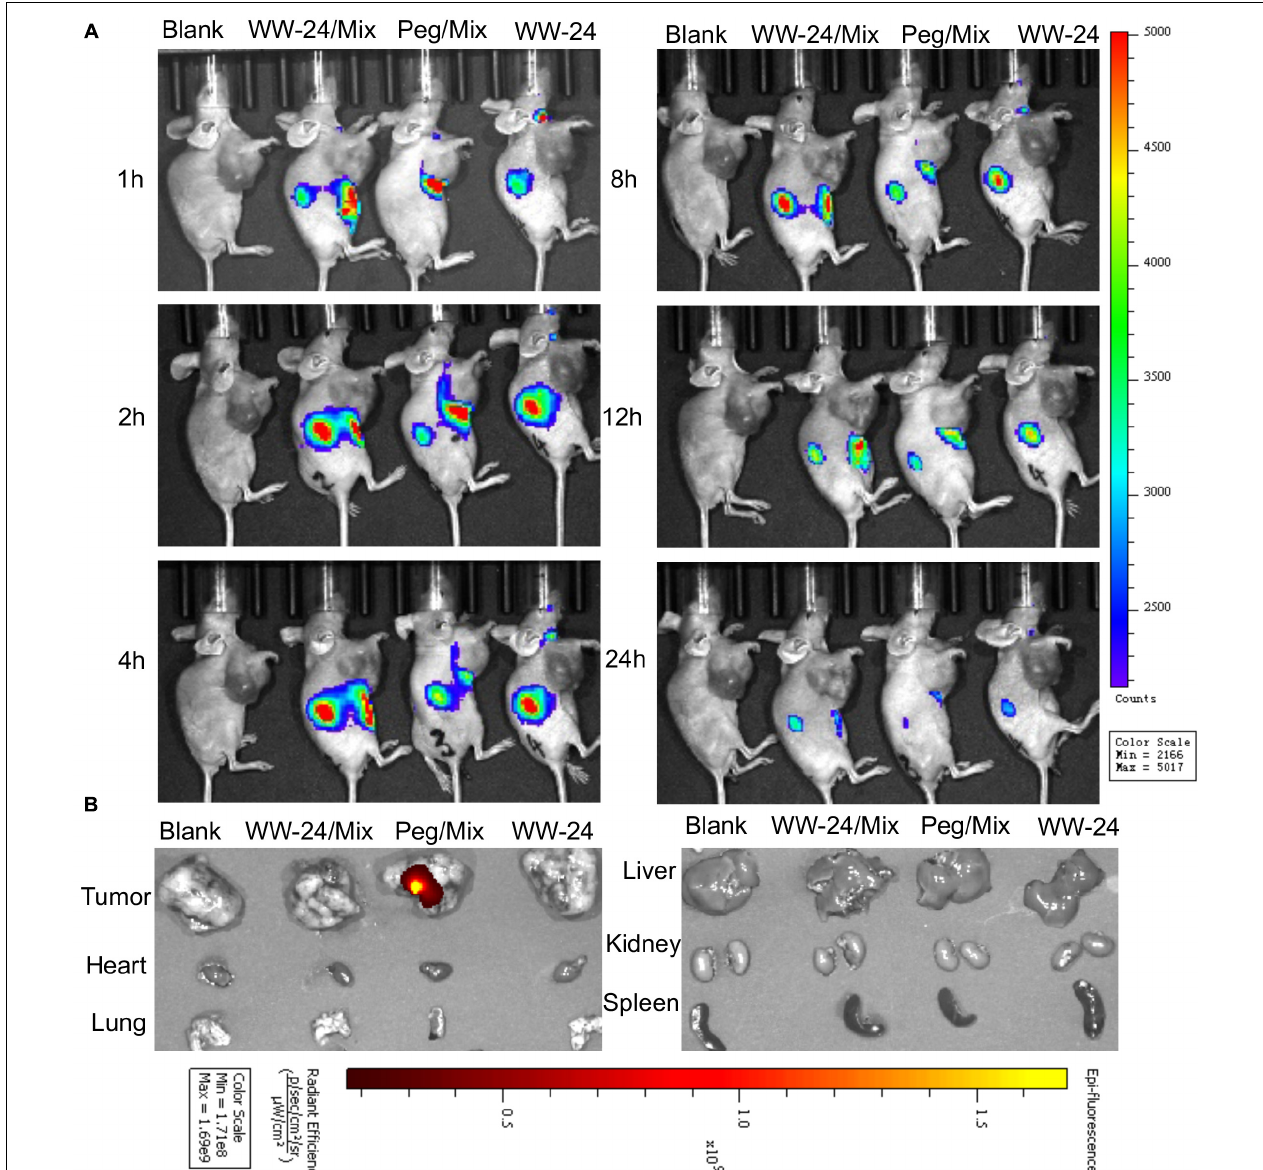
FIGURE 7 | Distribution of nanoparticles of WW-24/Mix with 1% PEG-2000 in vivo by peritumoral injection. The biodistribution of Cy7-labeled WW-24 was observed by an IVIS spectrum in vivo imaging system at the excitation wavelength of 745 nm and emission wavelength of 800 nm. (A) Typical in vivo imaging at 1, 2, 4, 8, 12, and 24 h (the black arrows show the tumor tissues). (B) Imaging of organs and tumors at 48 h excised from BALB/c nude mice ex vivo